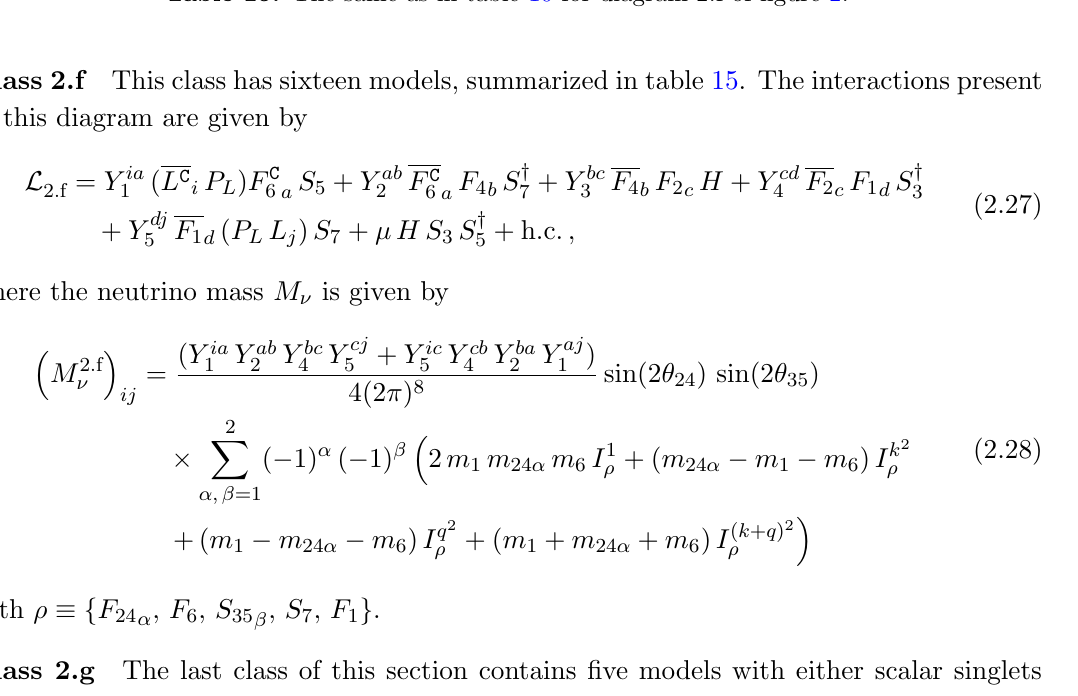
Table 15. The same as in table 10 for diagram 2.f of (cid:12)gure